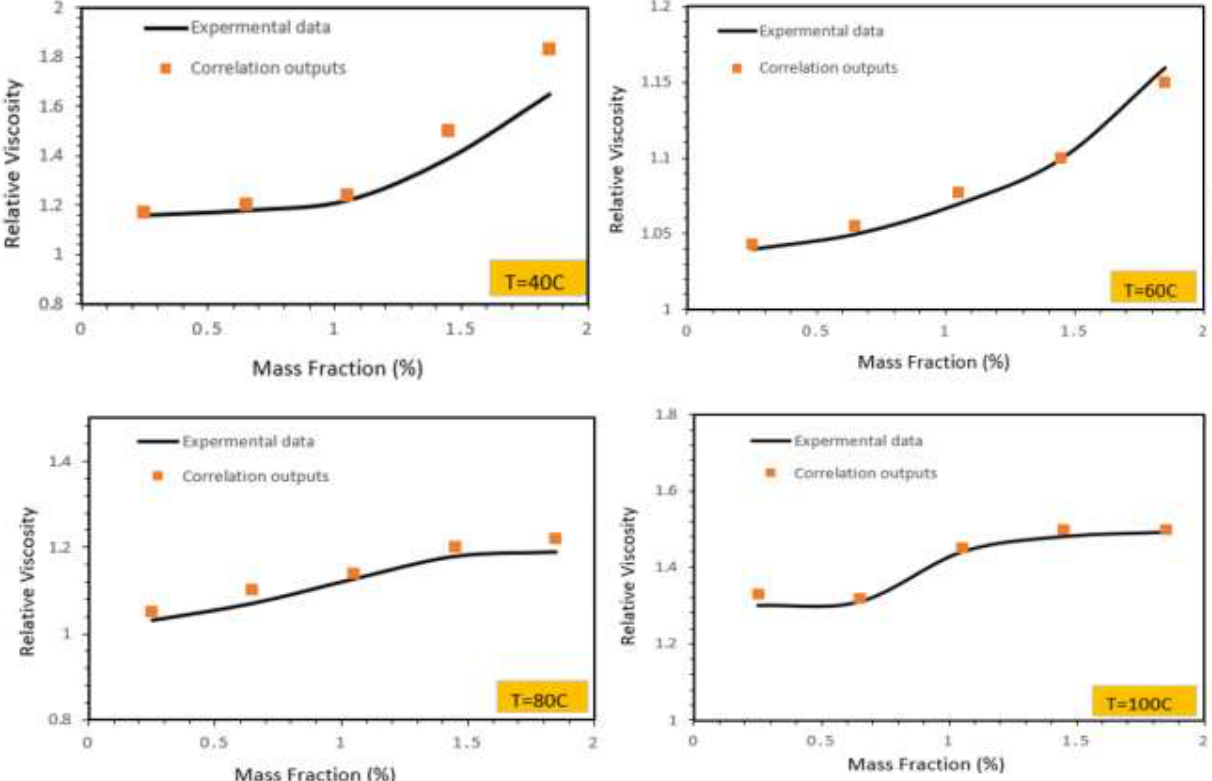
Figure 10: Comparison between Experimental data and correlation outputs with various mass fractions at T=40 o C, T=60 o C, T=80 o C, and T=100 o